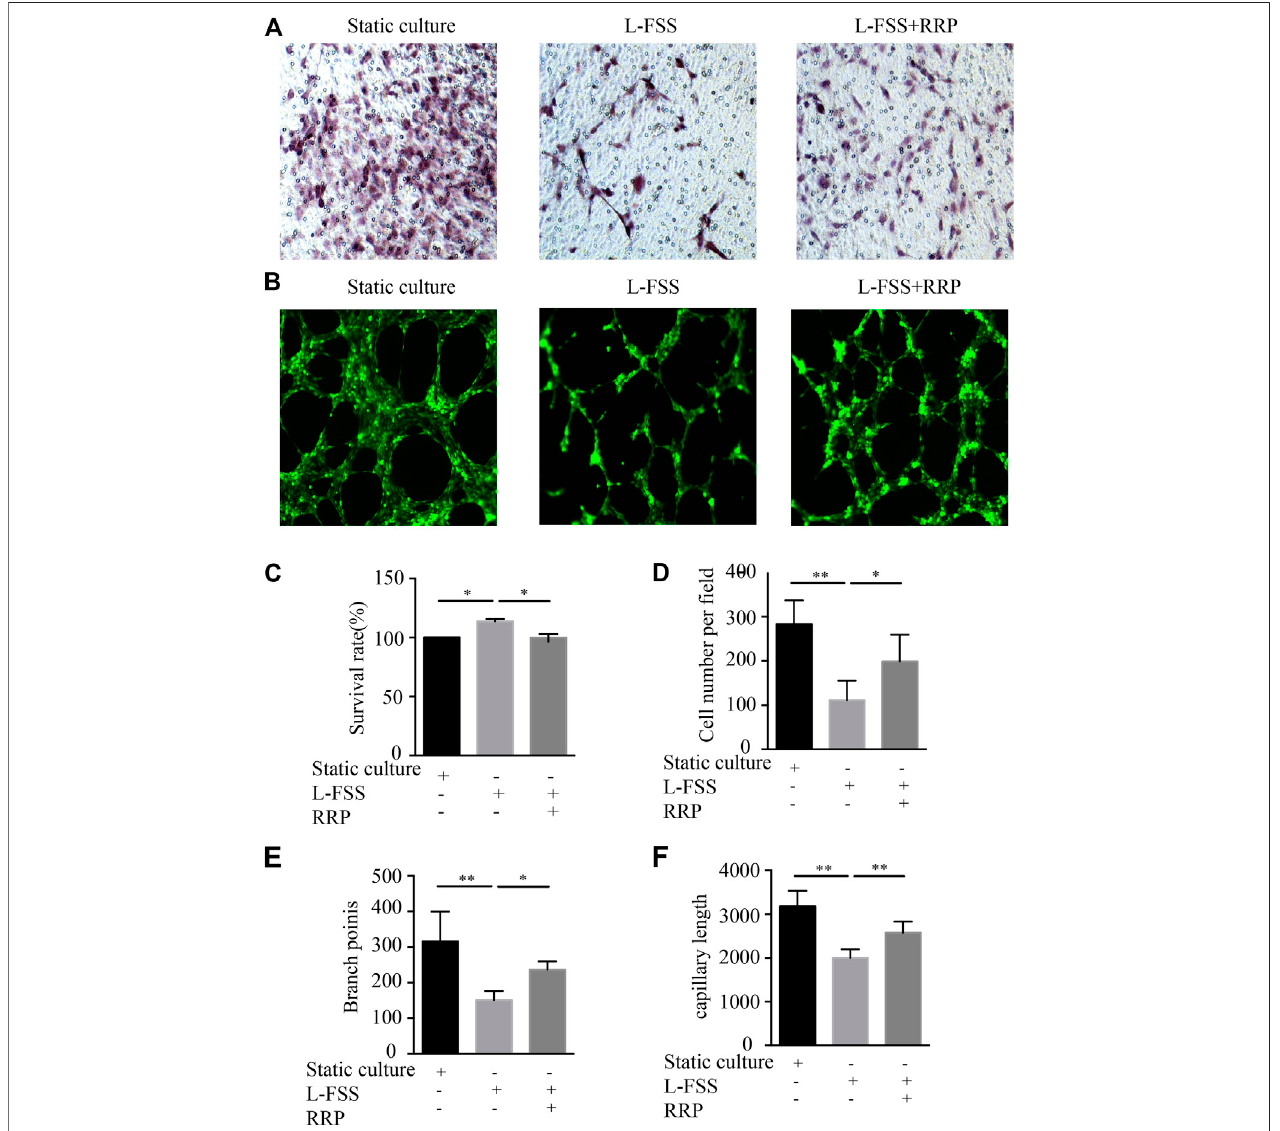
FIGURE4| RRPaffectsHUVECproliferation,migration,andtubuleformation. (A,D) RepresentativeimagesofthemigrationofHUVECsandthecalculatednumber of cells that migrated, scale bars (cid:2) 50 μ m, * p < 0.05, ** p < 0.001 vs. L-FSS group. (B) Representative images of the formation of capillary-like tubules in HUVECs, scale bars (cid:2) 200 μ m. (C) Proliferation activity of HUVECs, * p < 0.05 vs. L-FSS group. (E,F) Capillary morphogenesis was quanti fi ed by calculating the branch points (E) and capillary length (F) , * p < 0.05, ** p < 0.001 vs. L-FSS